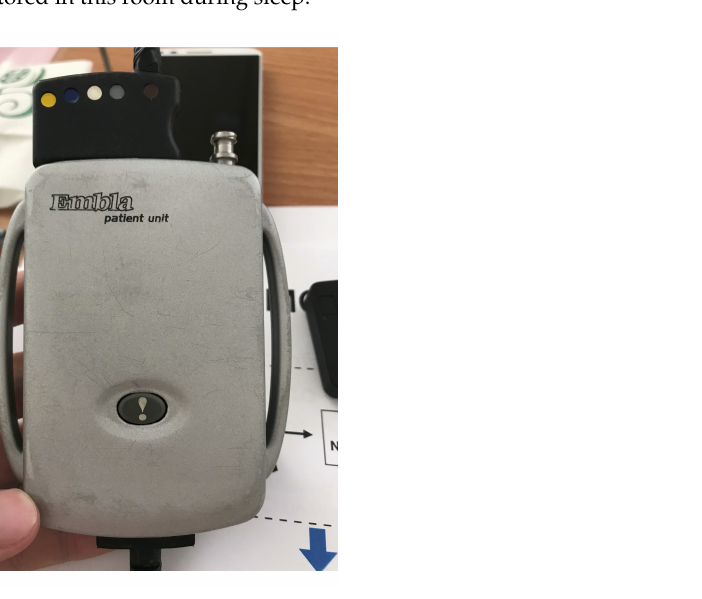
Figure 2. The attached device on the patient’s chest for monitoring body movement. The dimension of the device makes it a major disturbance during